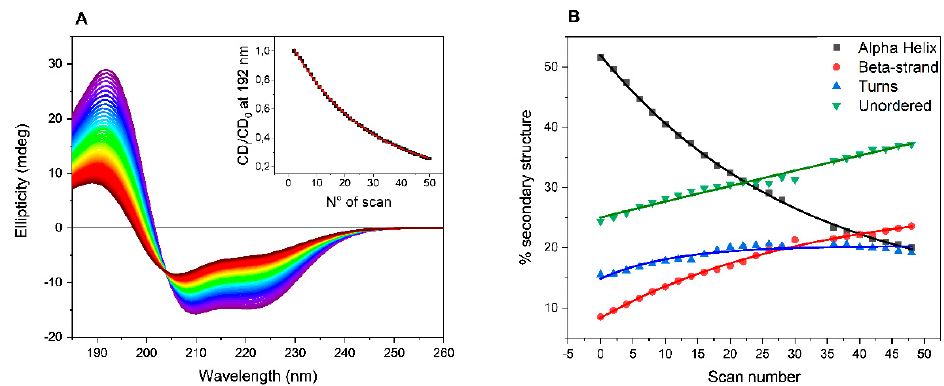
Table 1. A rapid process is characterized by higher decay rate and lower half-life values.